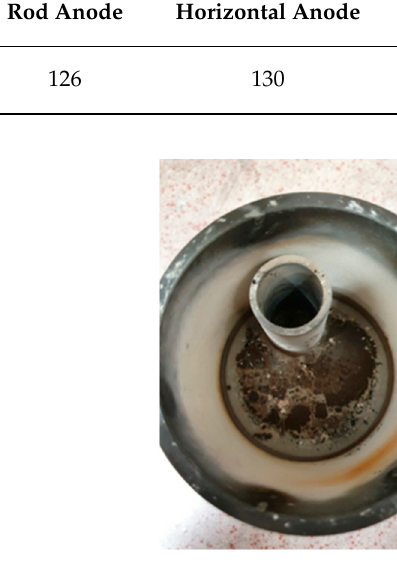
Figure 16. Image of the surface of the frozen bath in the silicon nitride crucible at room temperature after the experiment with the rod anode and inverted horizontal anode.